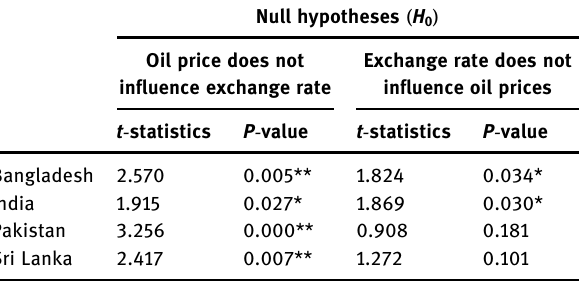
Table 4: Causality